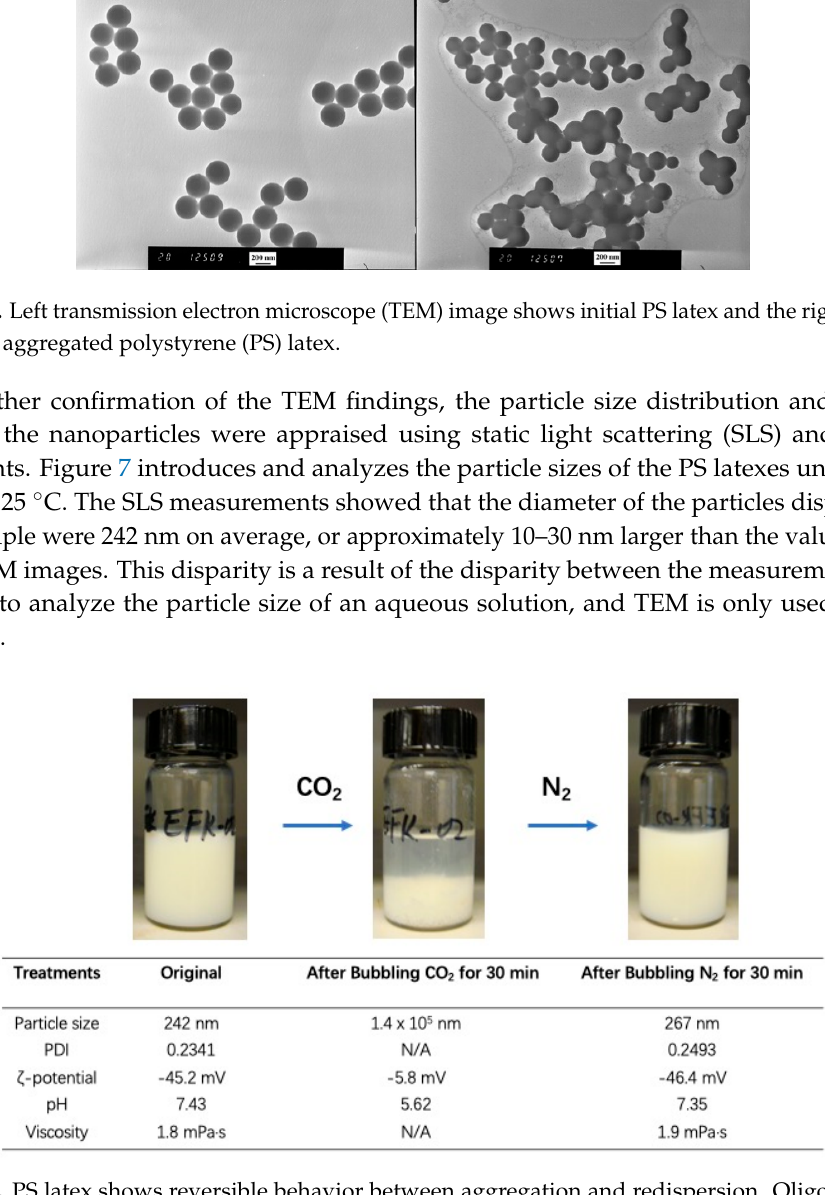
Figure 7. PS latex shows reversible behavior between aggregation and redispersion. Oligochitosan (0.15 g) was added to the PS latex (20 mL, left image), and then CO 2 (at a flow rate of 90 mL·min − 1 at 25 ± 0.5 °C for 20 min) was added (central image). Finally, N 2 (at a flow rate of 90 mL·min − 1 at 25 ± 0.5 °C for 20 min) was sparged into the latex (right image).